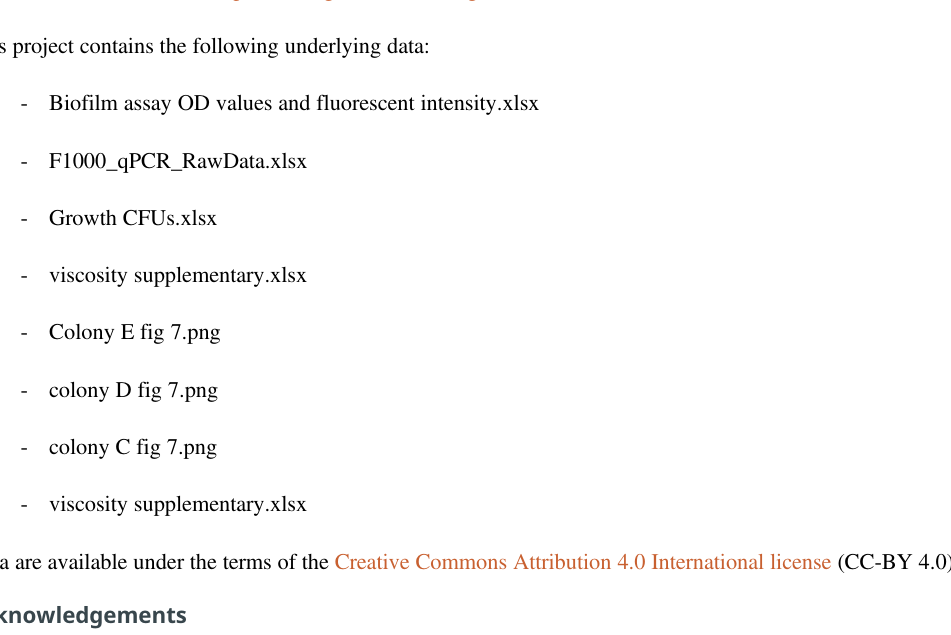
Figshare: Underlying data for “ Development of liquid culture media mimicking the conditions of sinuses and lungs in cystic fibrosis and health ” , https://doi.org/10.6084/m9.figshare.20463159.v6. 85 This project contains the following underlying